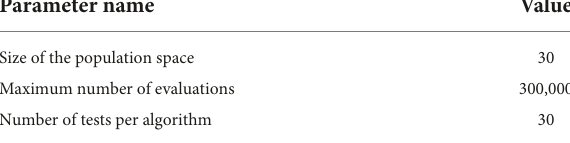
TABLE 5 Setting the baseline function experiment’s